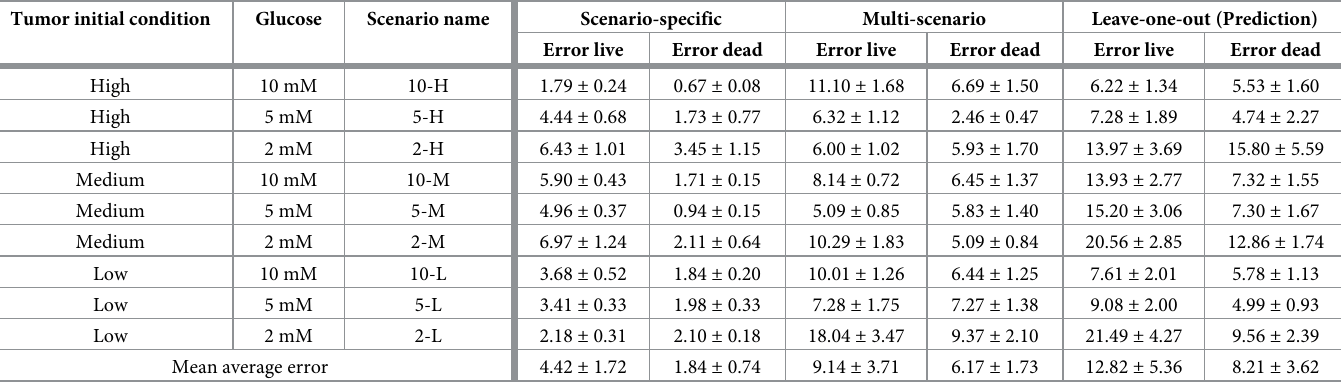
Table 2. Mean error and standard deviation.